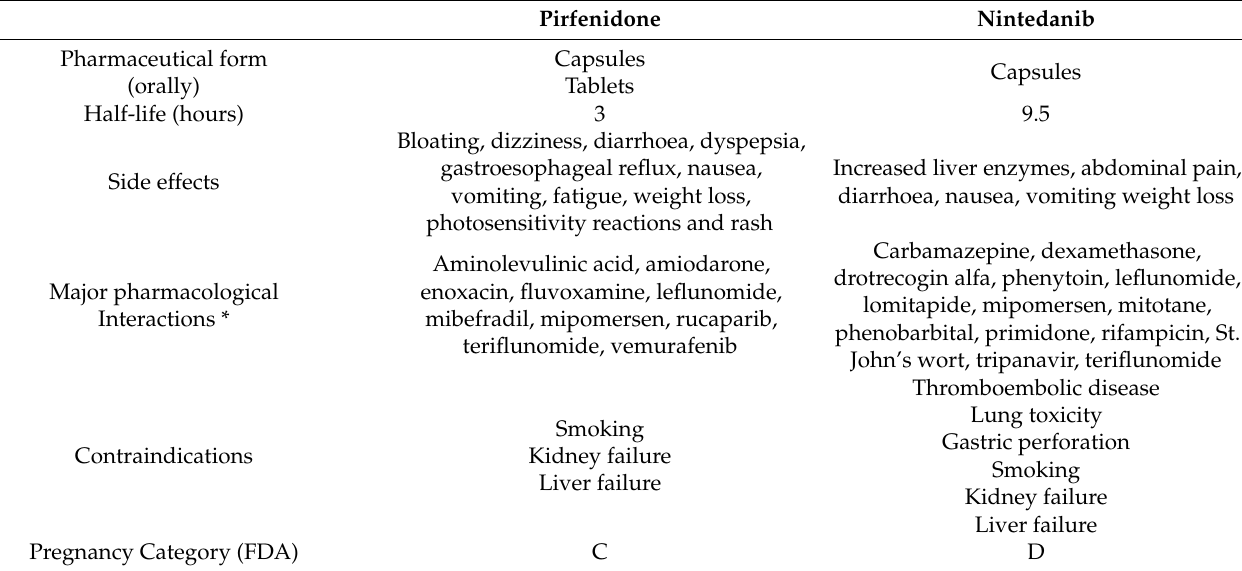
Table 2. Pharmacological characteristics of nintedanib and